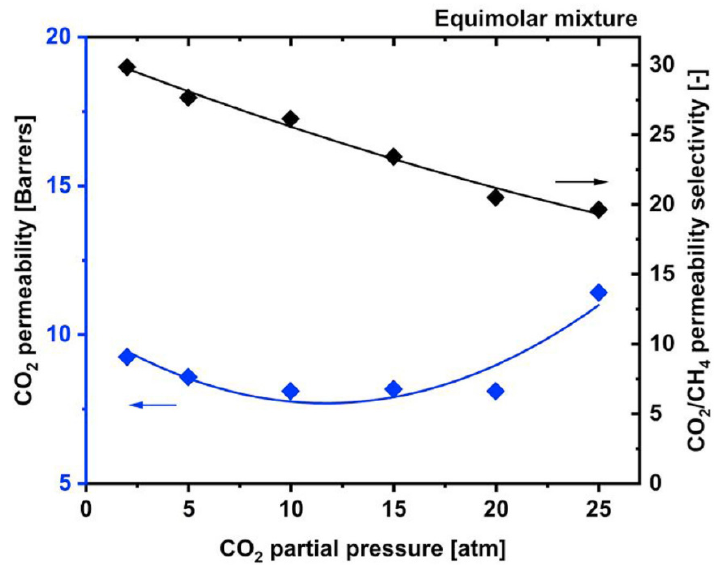
Figure 1. CA membrane performance trend for CO 2 /CH 4 mixed gas [47].